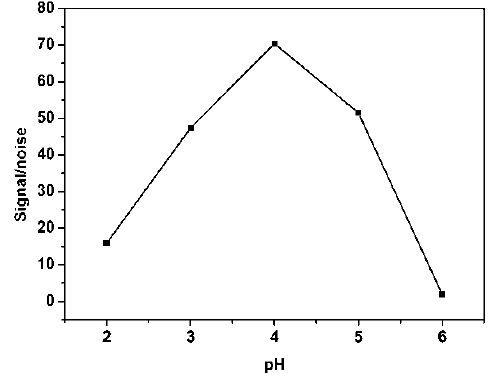
Figure 4. Signal/noise ratio versus the pH of sample. Experimental conditions: 20 µL gold nanoparticles (15 nm) was dissolved in 200 µL of aqua regia (2.0% HNO then 200 µL H O, 75 µL 0.1 M sodium tartrate and 1.0 M NaOH were added to adjust the 2 pH of the